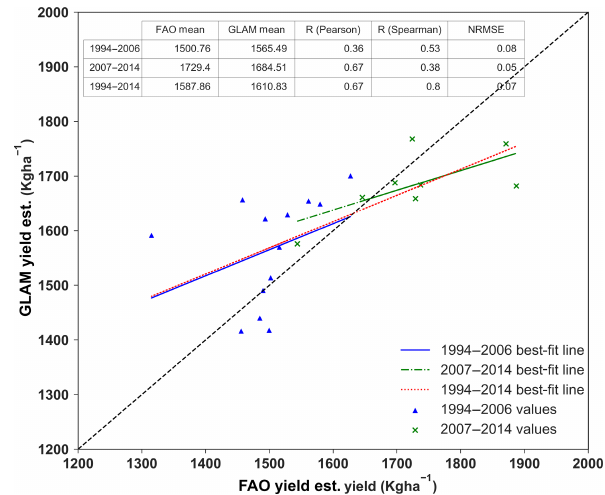
Figure 6. Scatter plot between FAO yield and GLAM-simulated yield. The red dotted line is the best-fit line for the whole period considered (1994–2014). The blue solid line shows the best-fit line for the period 1994–2006. The green line shows the best-fit line for the period 2007–2014.